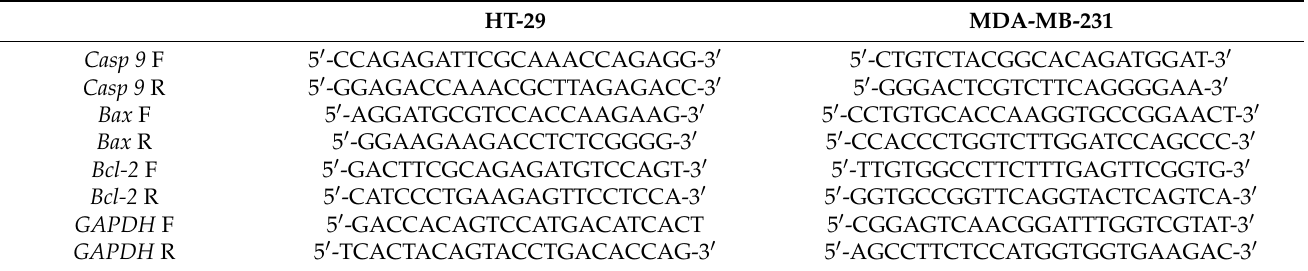
Table 1. Sequence of primers used to amplify Casp 9 , Bax, Bcl-2 , and GAPDH genes. HT-29